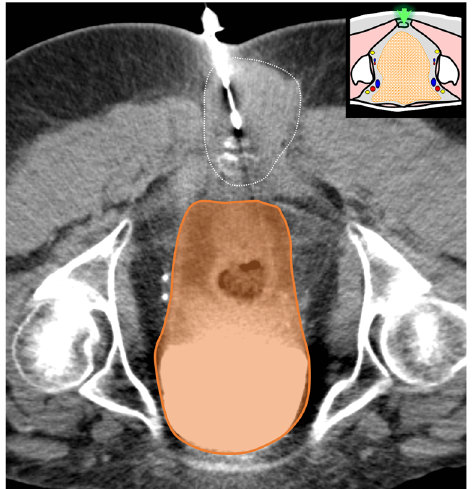
Fig. 13 A 62-year-old woman presenting with an expansive sacral lesion ( dotted line ) and no known primary tumour. After discussion with the orthopaedic surgeon, a posterior approach was selected for the biopsy with a 16-G cutting needle and the lesion proved to be a chordoma